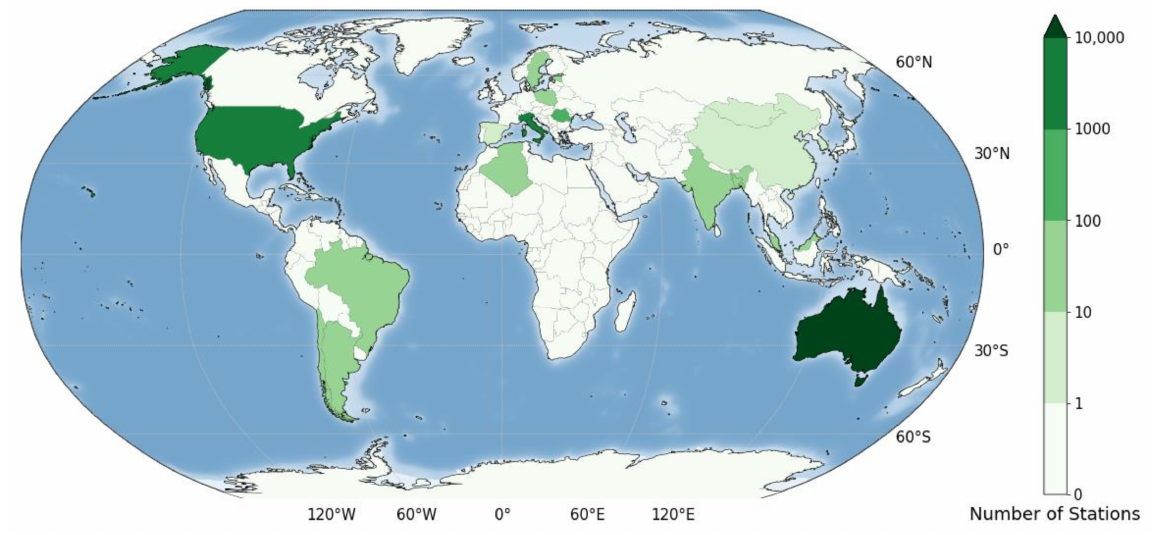
Figure 4. Geographical position of the rain gauge stations considered by Reference